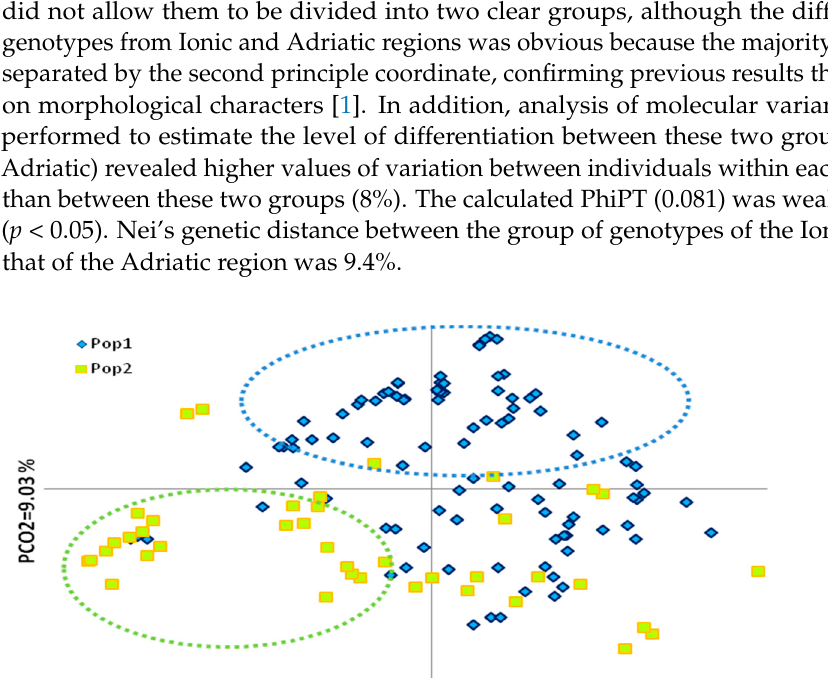
Figure 4. PCoA plot of 183 olive genotypes defined according to their fruit end-use. Pop 1—olive cultivars used for double purposes, Pop 2—cultivars used for oil production, Pop 3—cultivars used as table or canned olives production. PCoA indicated that, despite slight overlapping, the olive genotypes showed group- ing according to their origin and their area of distribution. The differentiation of geno- types according to their fruit end-use obtained in UPGMA analysis was not supported in the PCoA analysis. A model-based Bayesian approach was performed to infer the genetic structure of individuals under K = 2 clusters, which, as estimated by Evanno’s Δ K s statistics [44], re- sulted in the best fit to the model for olive genetic structuring. The proportion of its ge- nome derived from different clusters was estimated. The plot of the mean log-likelihood values (Ln(K) ± SD) averaged over 10 iterations and Evanno test for delta K are shown in Supplementary Figure S2. Genotypes were assigned to a cluster when 85% or more of their inferred genomes belonged to the cluster, with genotypes having a lower percentage being considered to be admixed [48]. Using a threshold of >85% for the designation of group representatives, 81 genotypes were assigned to group A (red bars) and 53 geno- types to group B (green bars), and the remaining 49 genotypes (26.7%) were assigned as admixed genotypes (Figure 5, Table S4).